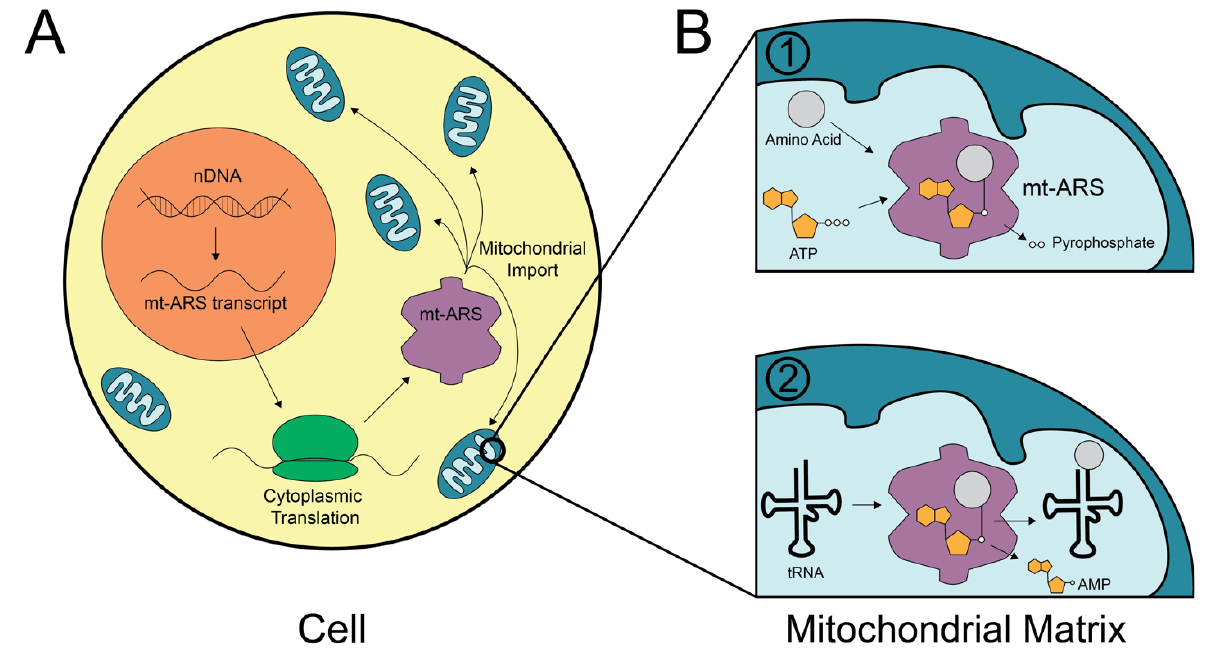
Figure 1. Mitochondrial aminoacyl-tRNA synthetases (mt-ARSs). ( A ) mt-ARSs are encoded by nuclear DNA (nDNA) and translated in the cytoplasm before being imported into the mitochondria. ( B ) mt-ARSs charge tRNA with corresponding amino acids in a two-step reaction (individual steps indicated by ‘1’ and ‘2’) in which the amino acid is first activated with ATP and then transferred to the tRNA molecule.